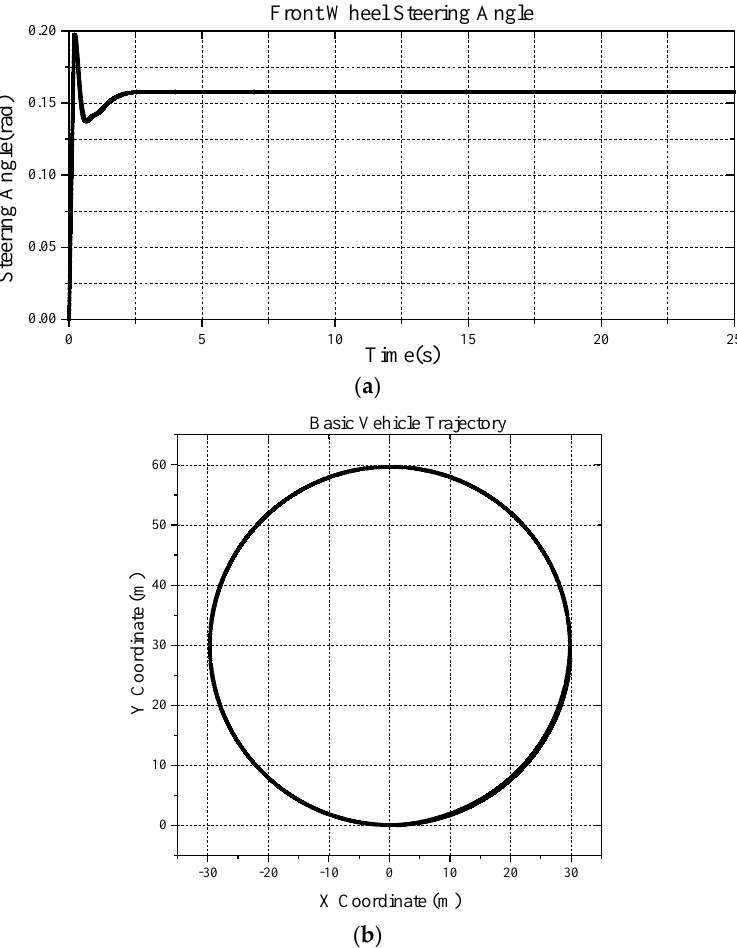
Figure 6. Simulation setup. ( a ) Command of front steering-wheel angle; ( b ) Desired neutral steering circle.